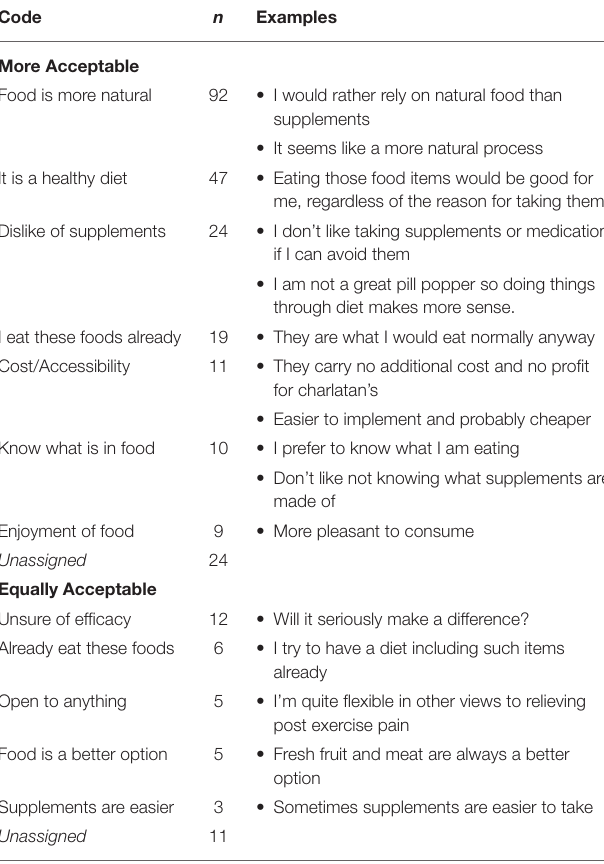
recovery compared to supplements a .